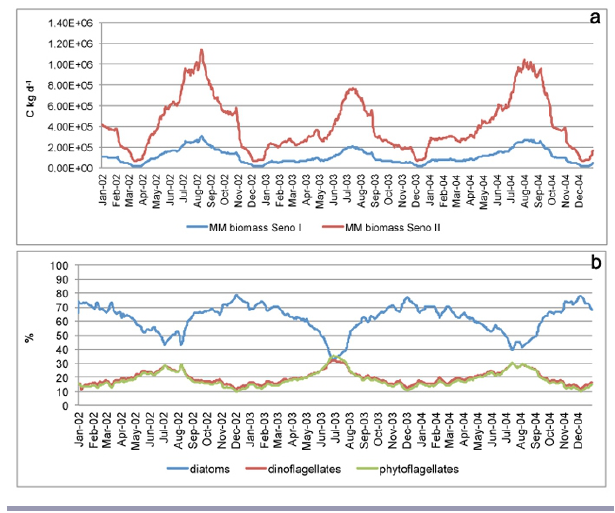
Fig. 9 . (a) Simulated mussels biomass (MM) in sub-basins Seno I and Seno II; (b) Simulated phytoplankton composition as % of biomass for three groups of phytoplankton in Seno